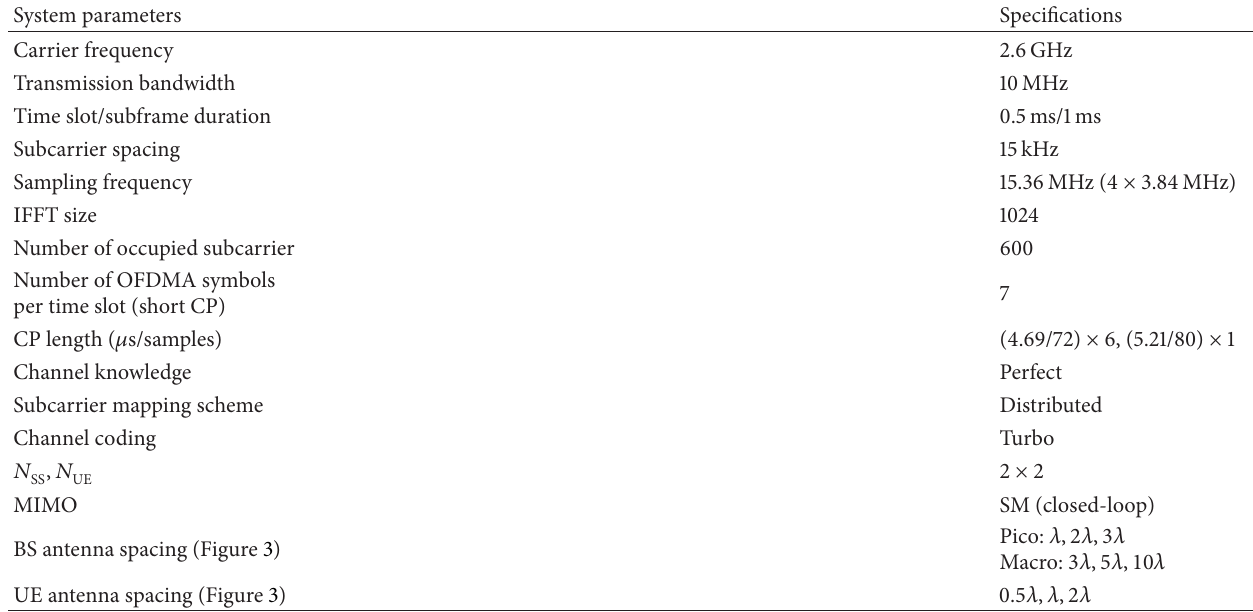
Table 1: Parameters for LTE-A